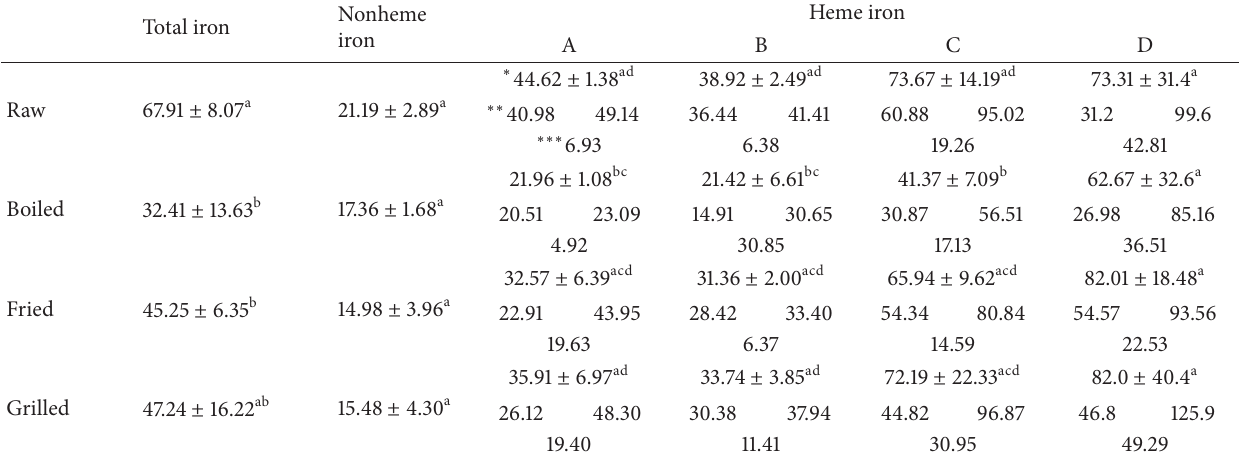
Grilled 47.24 ± 16.22 ab 15.48 ± 4.30 a